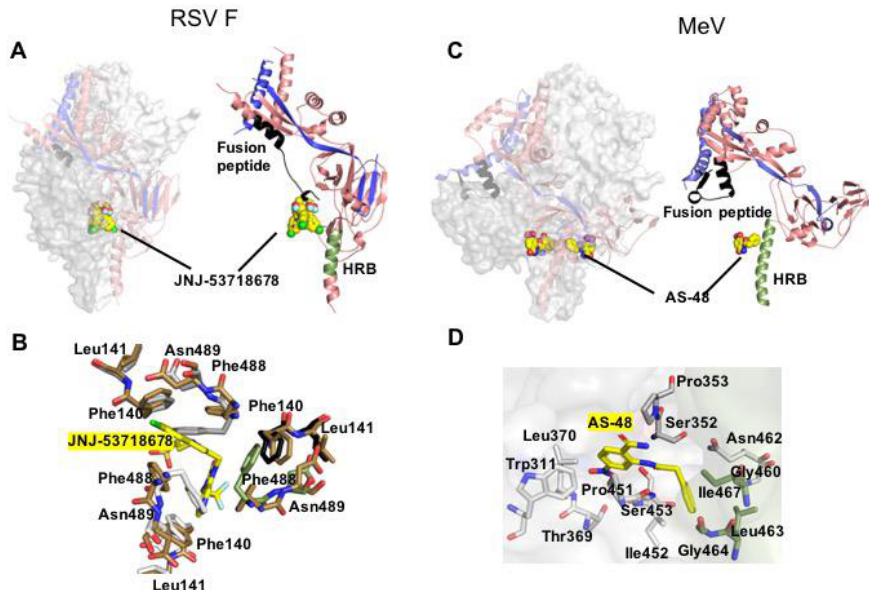
Figure 2. Prefusion pneumo- and paramyxovirus F structures complexed with small molecule inhibitors. ( A ) JNJ-53718678 (shown as yellow sphere) bound to RSV F (PDB 5KWW). The compound interacts with the base of the central F cavity and the fusion peptide, stabilizing the prefusion conformation. ( B ) Close-up of the hydrophobic binding pocket of JNJ-53718678 (yellow sticks) that involves all the three monomers of the F trimer. ( C ) MeV F in complex with small molecule entry inhibitor AS-48 (PDB 5YZC). The compound docks at the neck between F head and stalk, engaging residues in prefusion HR-B but not the fusion peptide. ( D ) Residue-view of the AS-48 (yellow sticks) target